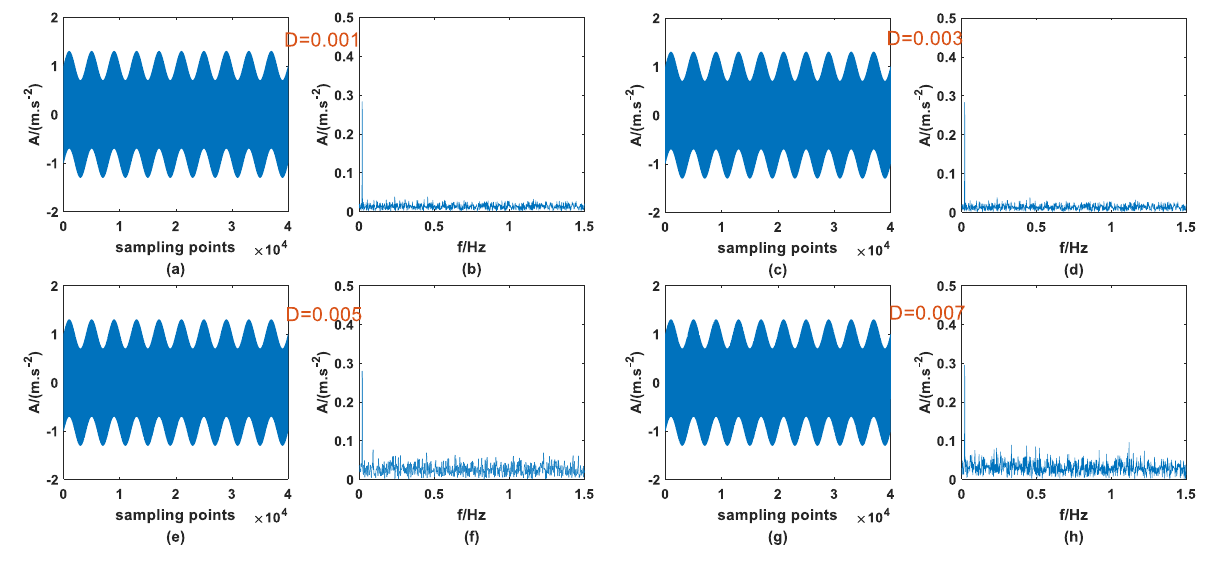
Figure 11. Input signal with dichotomous noise of different D ( a ) time domain ( D = 0.001), ( b ) frequency domain ( D = 0.001), ( c ) time domain ( D = 0.003), ( d ) frequency domain ( D = 0.003), ( e ) time domain ( D = 0.005), ( f ) frequency domain ( D = 0.005), ( g ) time domain ( D = 0.007), ( h ) frequency domain ( D = 0.007).